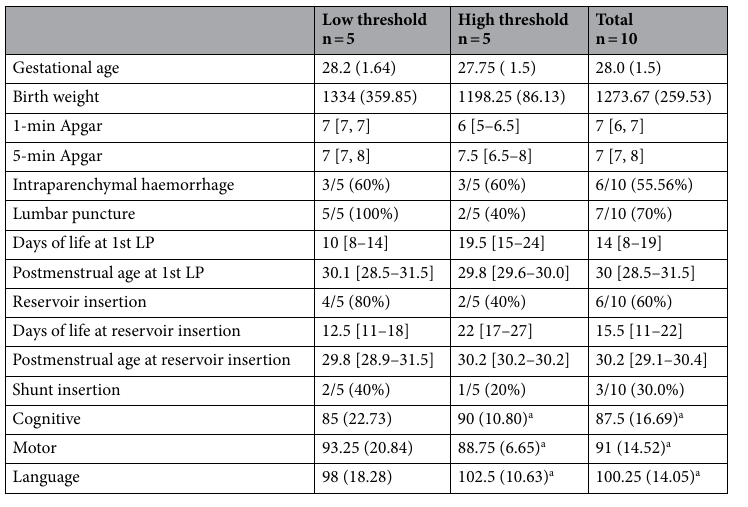
Table 1. Perinatal characteristics of the included patients classified by intervention group. Quantitative variables expressed as mean (SD) or median [IQR]. a One patient lost to follow-up from the high threshold